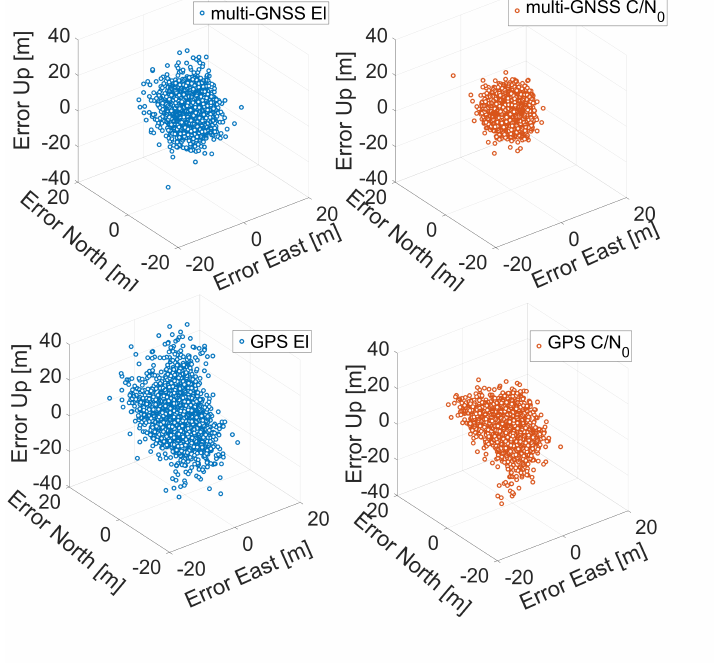
Figure 7. Three-dimensional coordinate error scatter plots for single point positioning of Xiaomi Mi 8. The first row corresponds to multi-GNSS solution while the second row to the GPS one. Blue markers represent errors when the solution was obtained using elevation-dependent weights; red circles represent errors obtained using C / N 0